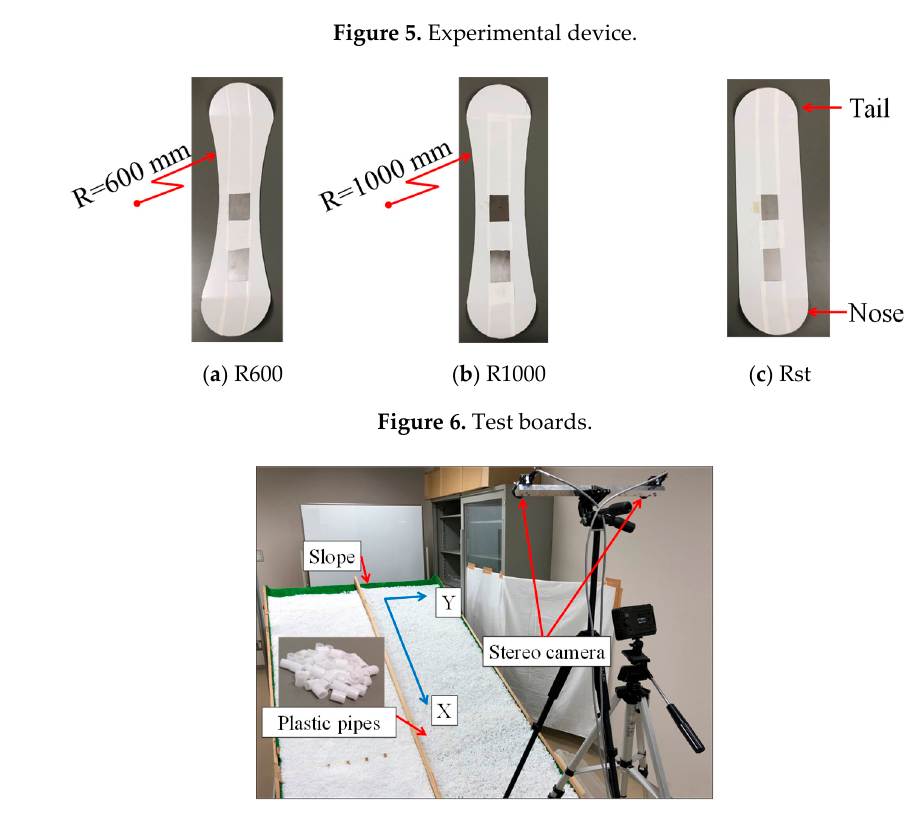
Figure 7. Slope and stereo camera for the